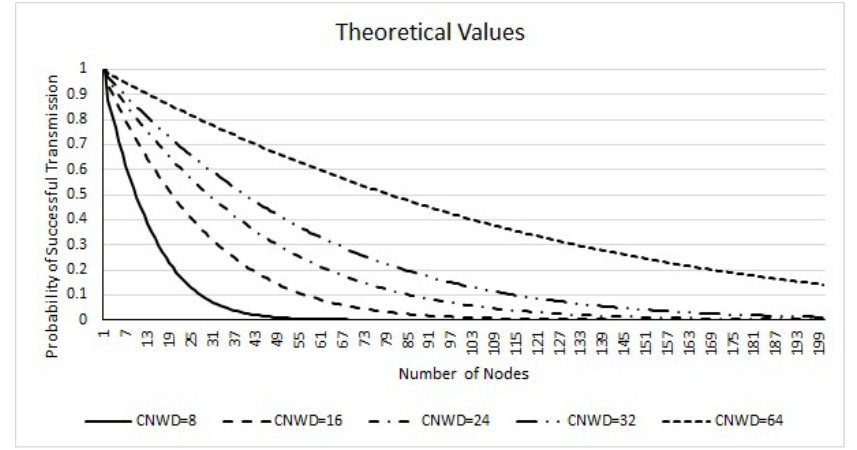
Figure 1. Theoretical